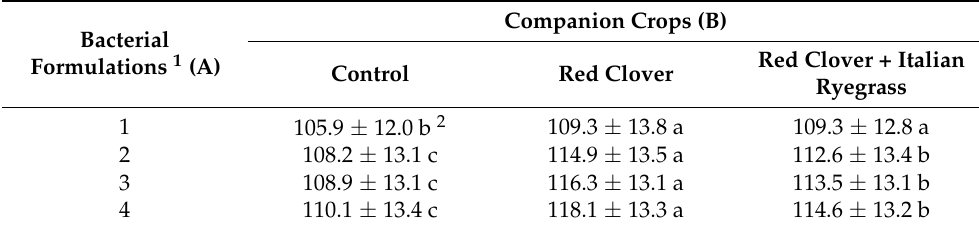
Table 3. Total protein content in spring barley grain according to test bacterial formulations and companion crops (means across 2019–2021), g · kg − 1